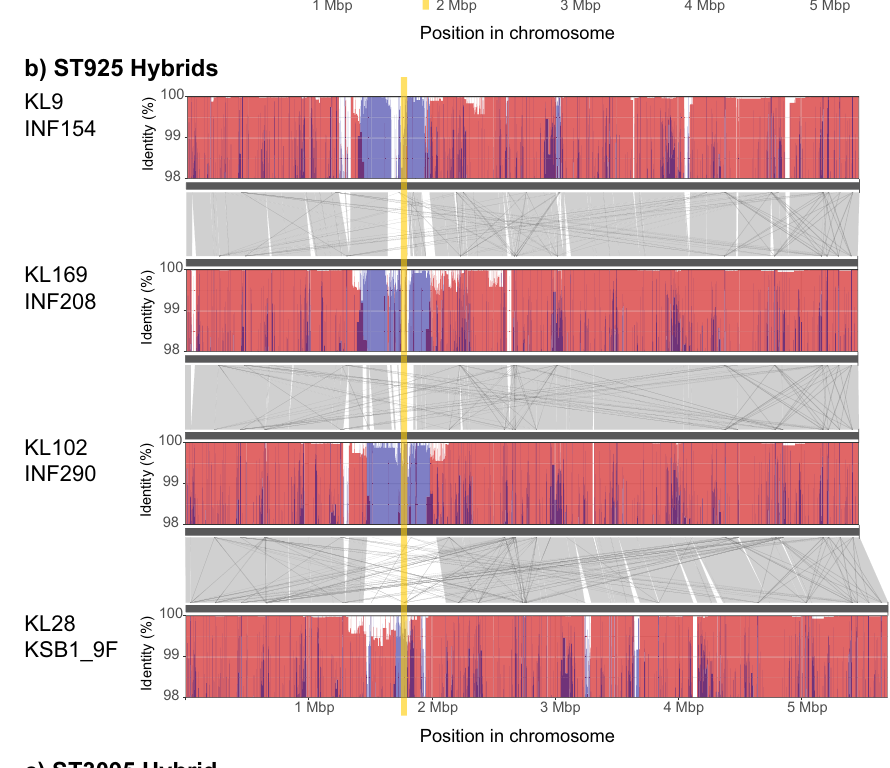
NATURE COMMUNICATIONS| (2022) 13:3017